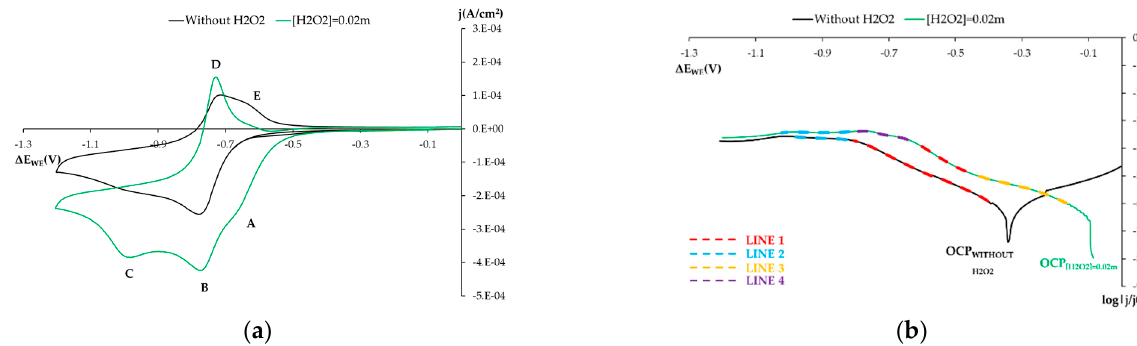
Figure 8. ( a ) Voltagrams obtained with the SS sensor in 0.1 m NaOH solution and 0.02 m H 2 O 2 . ( b ) Voltagrams of the Figure 8a logarithmically represented, only cathodic sweeping. Black line: without H 2 O 2 . Green line: With [H 2 O 2 ] = 0.02 m. Table 7. This table summarizes data for the lines related to Figure 8b.